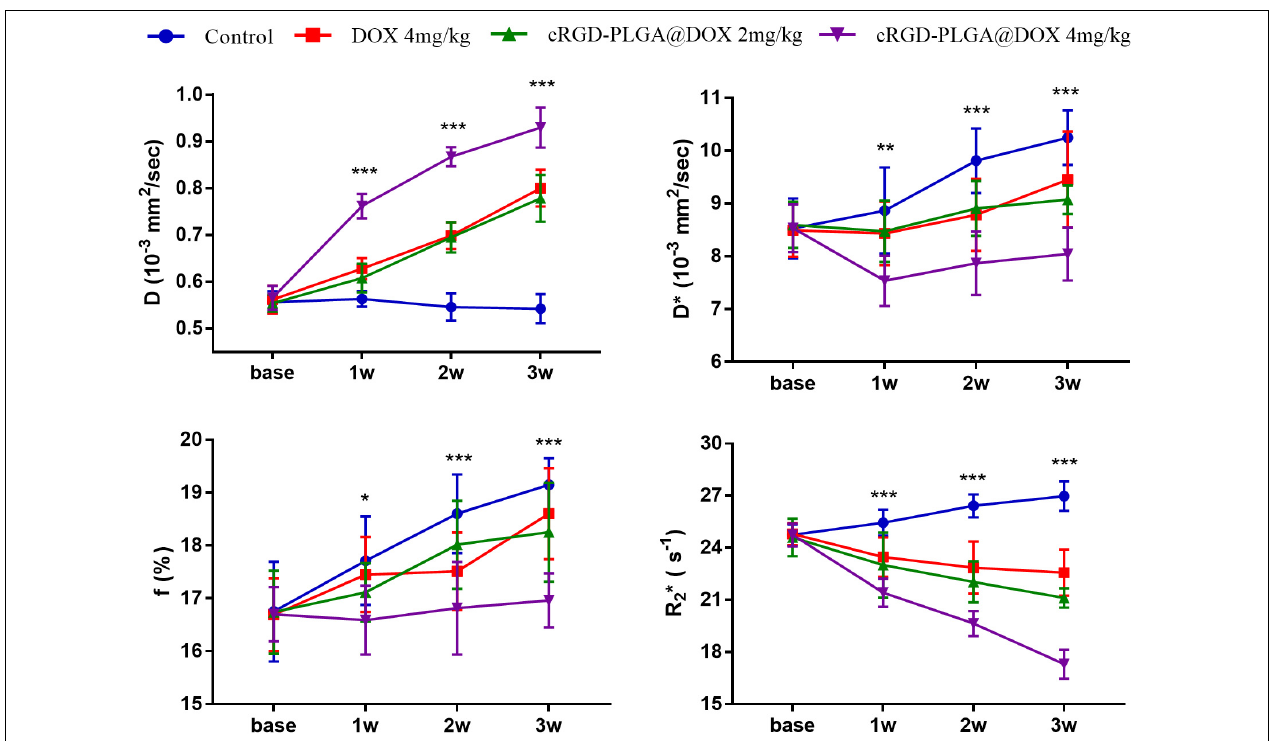
FIGURE 7 | Longitudinal monitoring of IVIM-DWI and R2* mapping in the four groups. The data point indicated mean and standard deviation. * P < 0.05, ** P < 0.01, and *** P < 0.001 were generated from comparisons between the four groups at each time point using one-way analysis of variance.